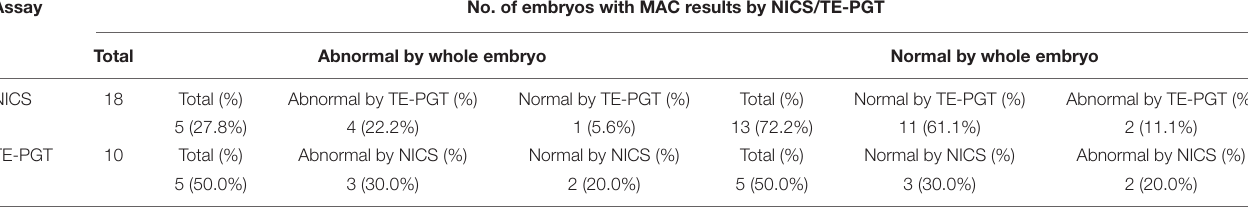
TABLE 5 | Characteristics of embryos with results of MAC (group C) obtained from NICS or TE-PGT assay. Assay No. of embryos with MAC results by NICS/TE-PGT Total Abnormal by whole embryo Normal by whole embryo Abnormal by TE-PGT (%) Normal by TE-PGT (%) Total (%) Normal by TE-PGT (%) Abnormal by TE-PGT (%) Normal by NICS (%) Normal by NICS (%)